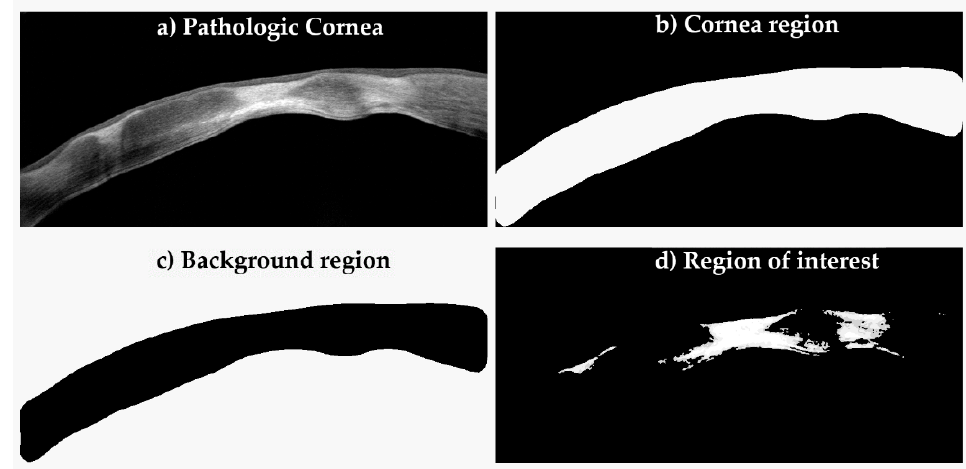
Figure 2. Digital image segmentation process. In order to extract statistical features, image segmentation was performed into different portions.